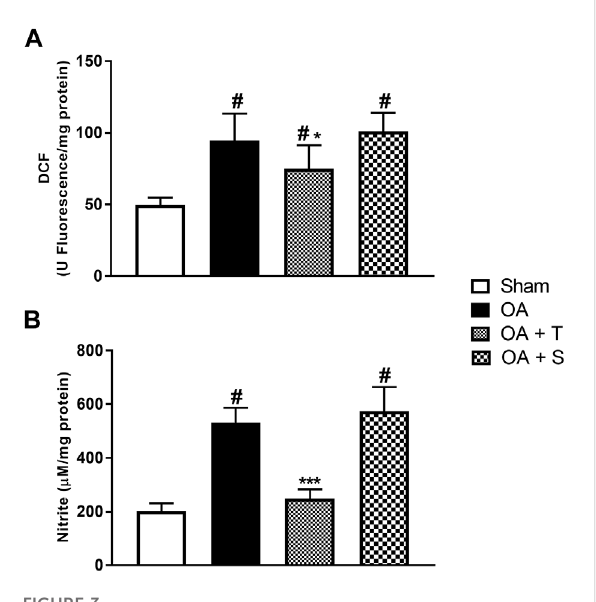
FIGURE 3 Oxidants. (A) DCF; (B) Nitrite. Abbreviations: DCF, dichloro fl uorescein; OA, osteoarthritis. Data are presented as mean ± SEM, in which: # p < 0.05 vs. Sham Group; * p < 0.05 vs. OA Group; *** p < 0.001 vs. OA Group; (One-way ANOVA followed by Tukey post-hoc